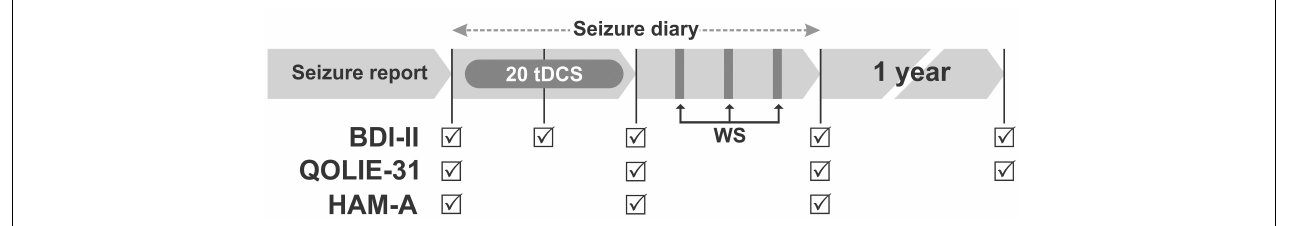
FIGURE 1 | Each arrow corresponds to a 30-day period, except the last (1-year follow up). Patients self-administered 20 sessions of tDCS at home during 20 min daily (20 tDCS), 5 days a week for 4 weeks. Next, three maintenance consecutive weekly sessions (WS) of tDCS’s were applied in the research laboratory. To assess the frequency of seizures, patients filled in seizure reports during a month prior to the start of treatment and kept a seizure diary from day one to day 60 of the study. Participants were evaluated on days 1, 15, 30, 60, and after 1-year follow up of the study using the Beck Depression Inventory II (BDI II). The Inventory for Quality of Life in Epilepsy (QOLIE-31) was evaluated on days 1, 30, 60 and after 1-year follow up. The Hamilton Anxiety Scale (HAM-A) were applied only on days 1, 30 and